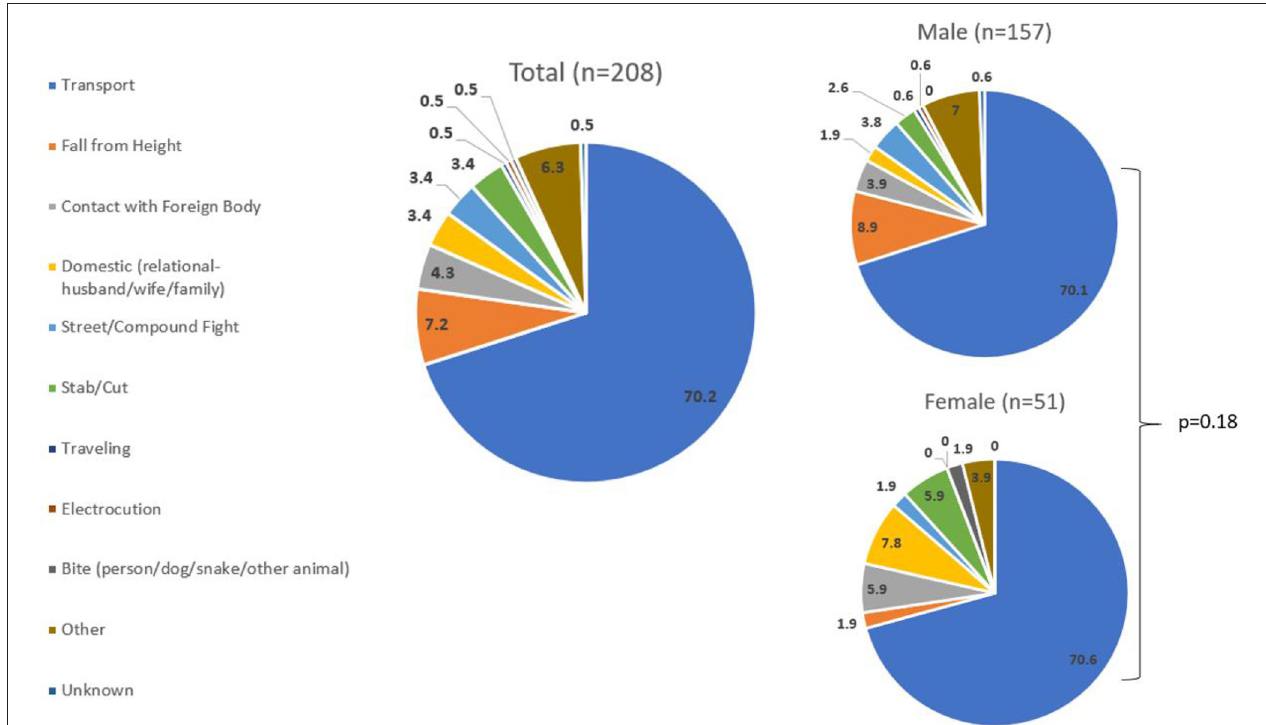
FIGURE 2 | Mechanism of injury amongst head-injured patients, stratified by sex